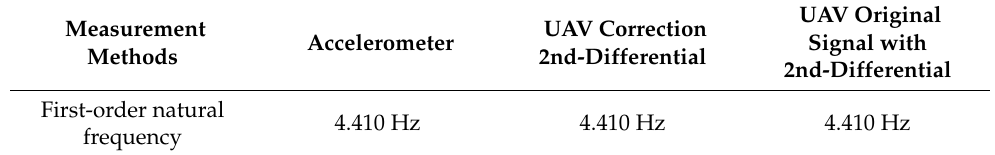
Figure 12. Modal parameter identification results of accelerometer measurement. Table 3. Identification results of 3 measurement